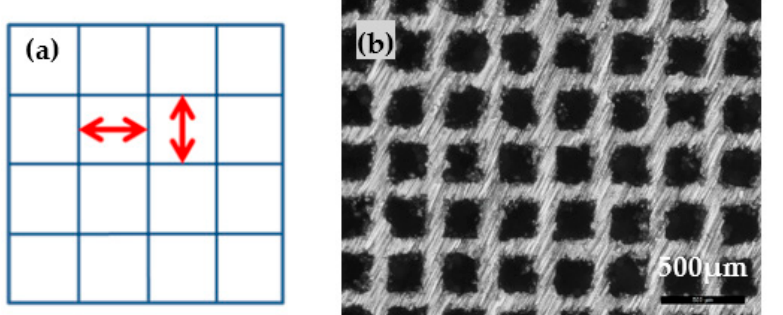
Figure 4. Square pattern. ( a ): Blue lines depict line scan of the laser, red arrows correspond to the applied hatch distance. ( b ): microscopic picture of an exemplary square pattern.